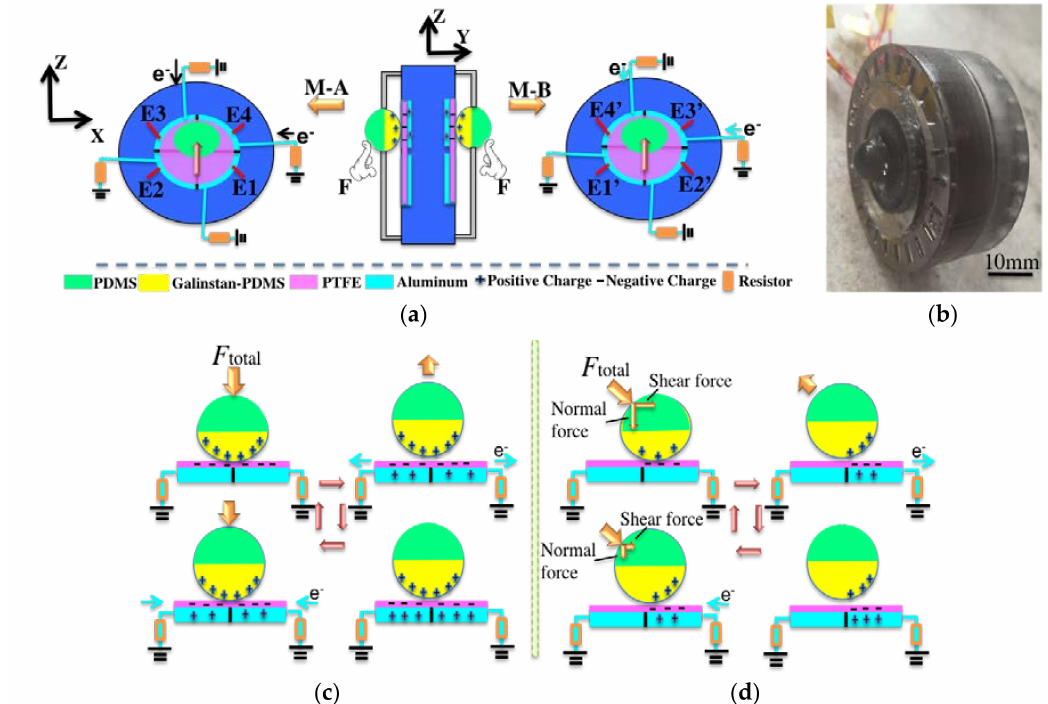
Figure 2. ( a ) The symmetrical structure of the self-powered sensor. ( b ) Photo of the fabricated sensor. ( c ) The working mechanism of the six-axis self-powered sensor under normal force. ( d ) The working mechanism of six-axis self-powered sensor under shear